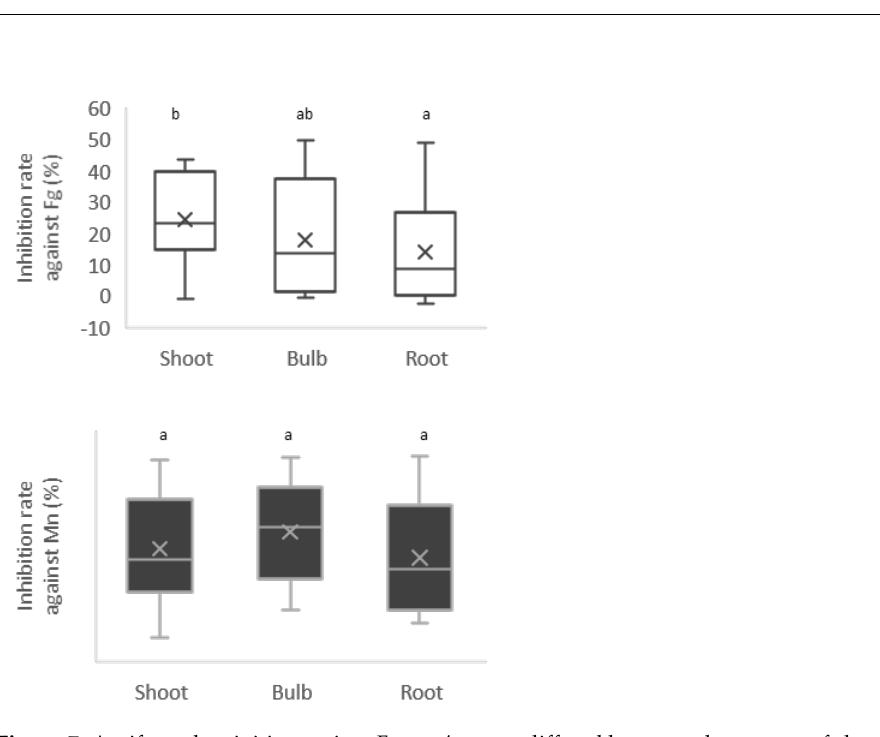
Figure 7. Antifungal activities against F. graminearum differed between the groups of shoot and root bacterial collections, but there was no difference in the antifungal activities for M. nivale . Different letters (a, b) show significant difference with p < 0.05 by the Tukey – Kramer method.